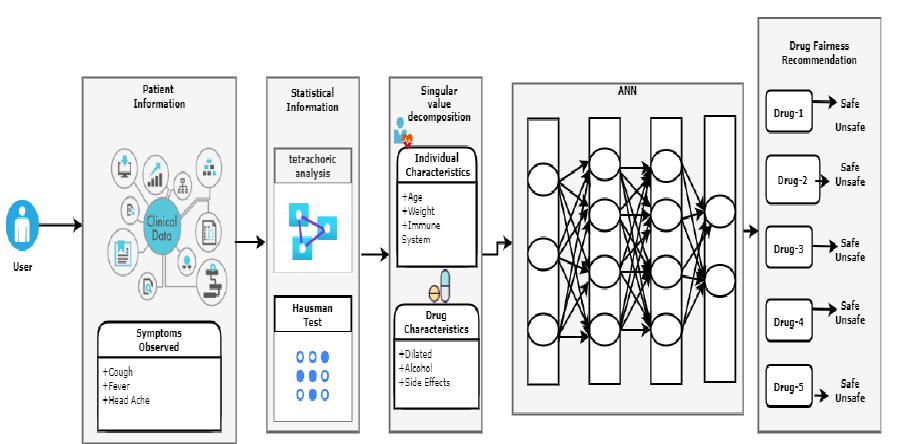
Figure 1. Block diagram for the proposed recommender system.